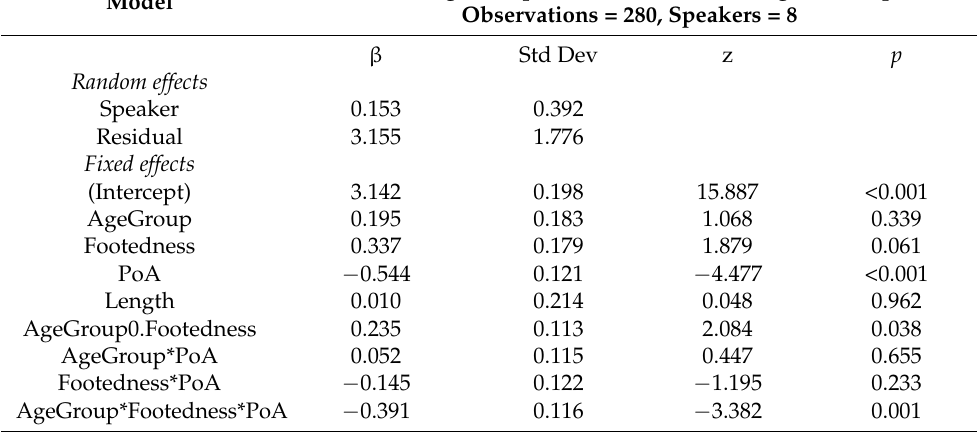
Table 4. Results of Linear Mixed Effects model exploring factors influencing reduction of utterance- final past tense